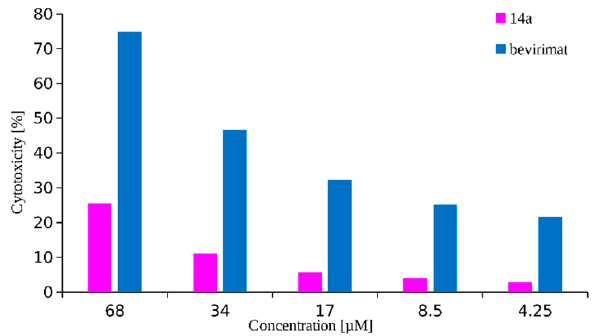
Figure 3. Cytotoxicity of compound 14a and BVM (reference) in the tested concentration range.